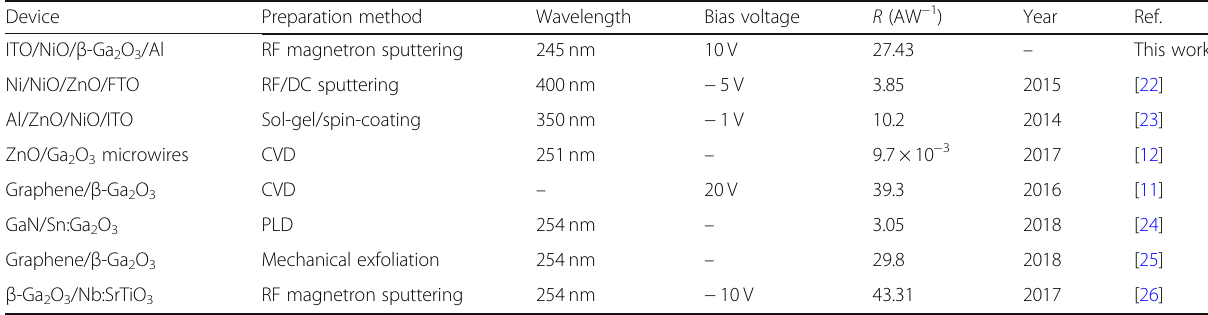
Table 1 Comparison of characteristic parameters of other NiO-based and Ga 2 O 3 -based UV detectors Device Preparation method